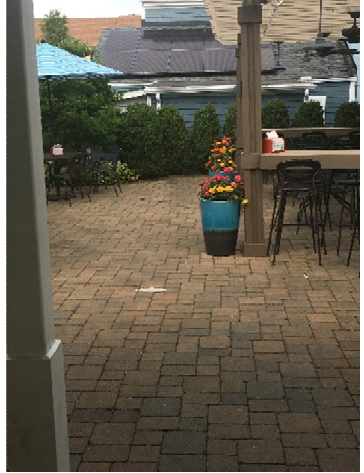
Figure 3. A planter with bright flowers on a paved patio.